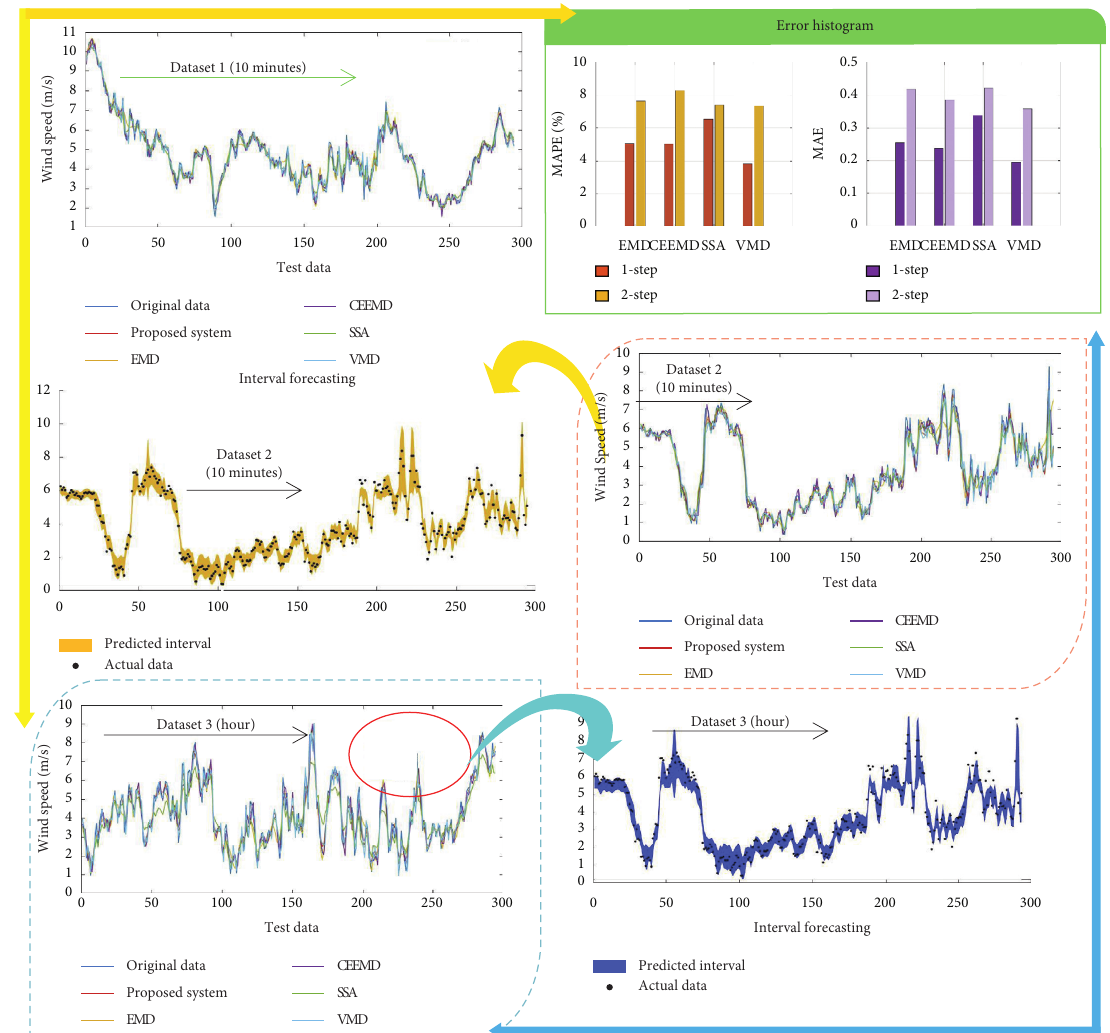
Figure 3: Experiment II: comparison with models employing diverse data pretreatment